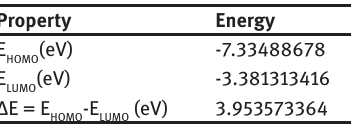
Figure 6 : Frontier molecular orbitals of N -acetylisatin. Table 4 : HOMO-LUMO energies of N -acetylisatin